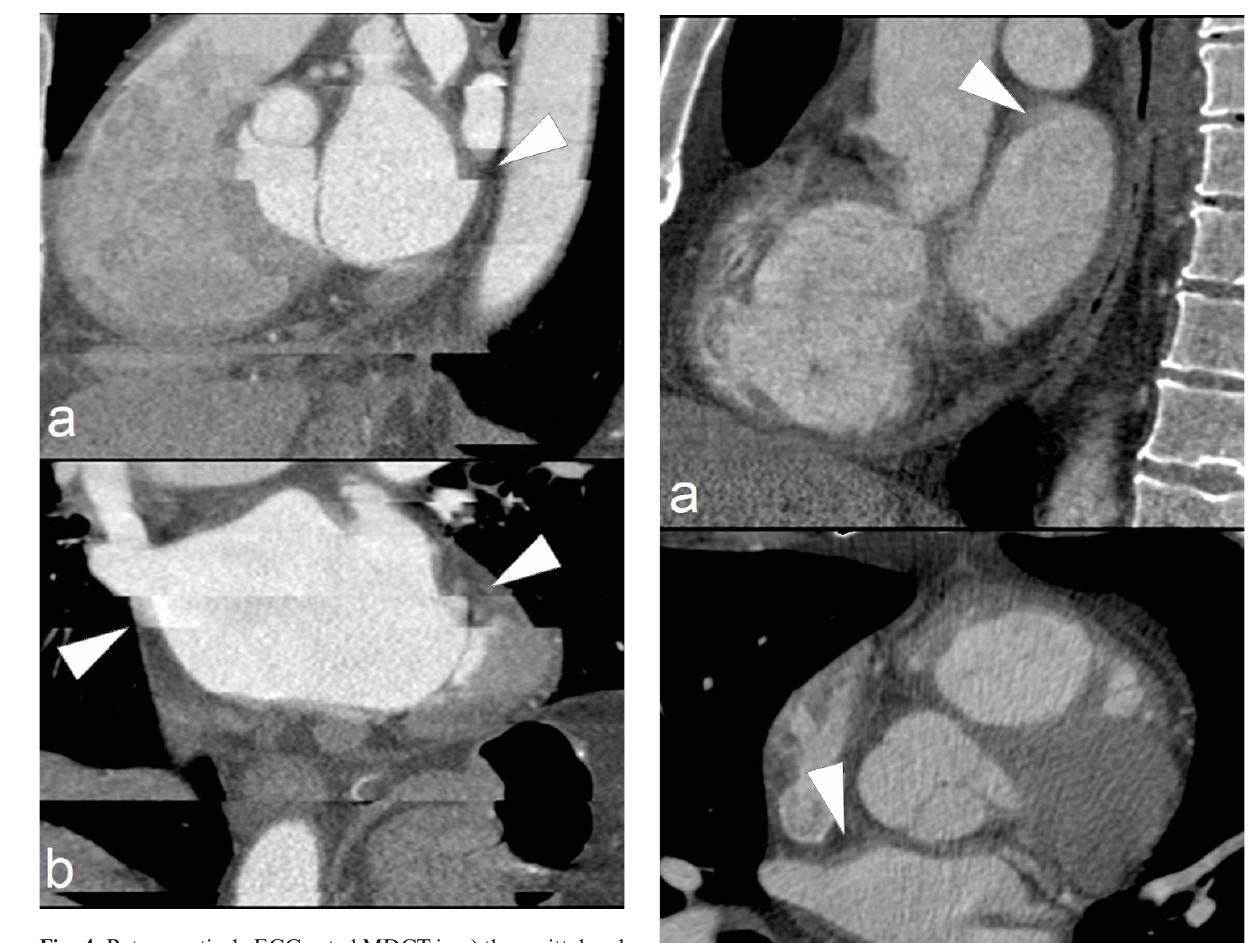
Fig. 4. Retrospectively ECG-gated MDCT in a) the sagittal and b) the coronal plane; the images show stair-step artifacts on the surface of the left atrium (arrowheads) resulting from incorrect data registration; the visual image quality was graded as “poor”.